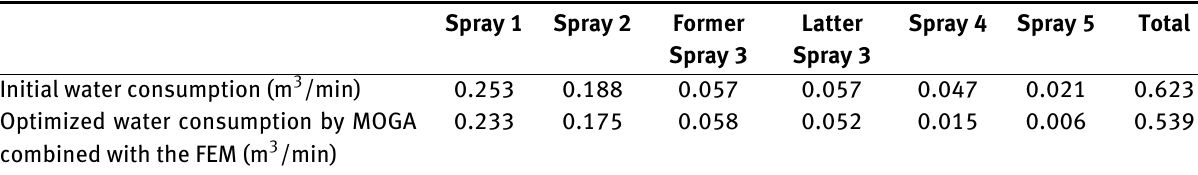
Table 3: Comparison of water consumption before and after optimization.